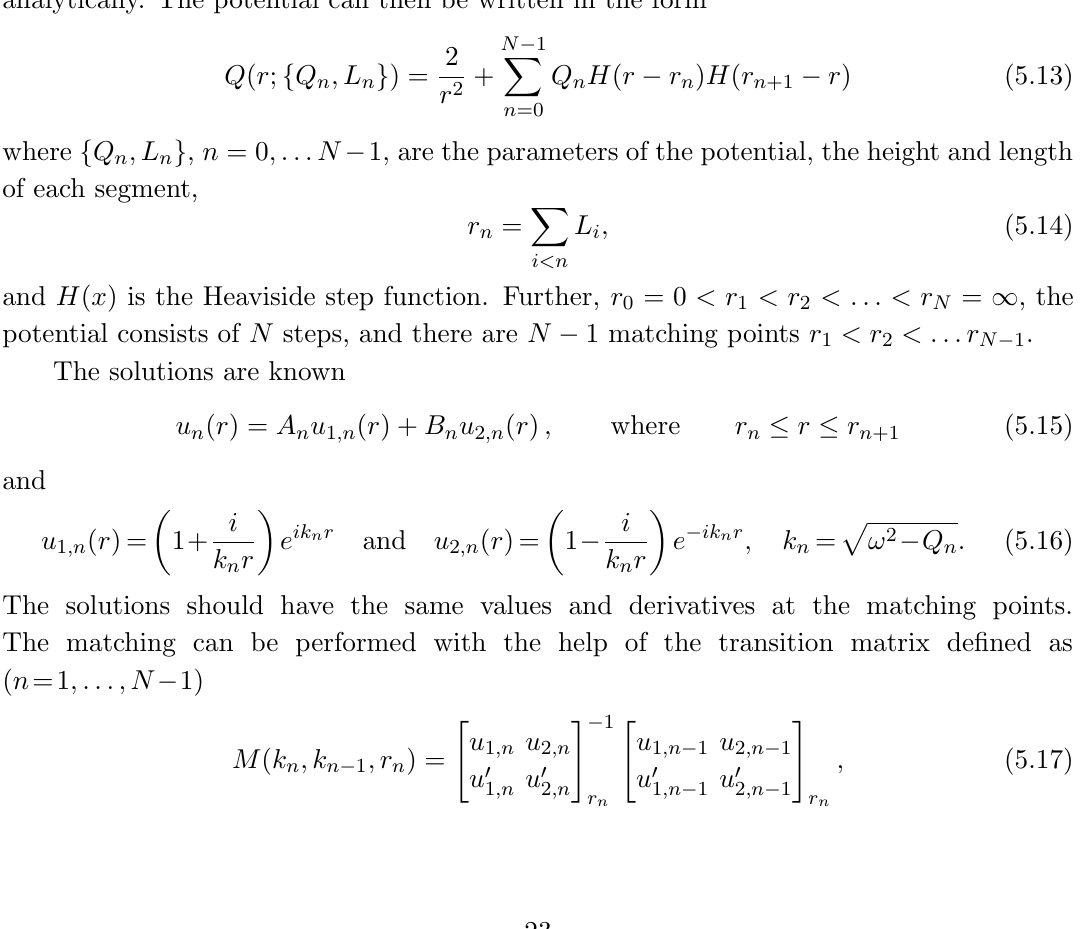
Figure 17 . Reconstruction of the (cid:12)eld theoretic potential pro(cid:12)les of the solutions; (ii) the e(cid:11)ective potential Q with the 3-dimensional universal repulsive core subtracted; (iii) the (cid:12)eld theoretical potentials the resonances is described in the